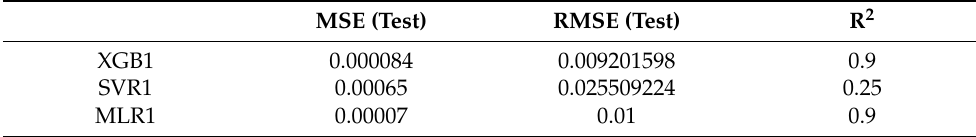
Table 9. Performance metrics of RGB vs. θ machine learning models.